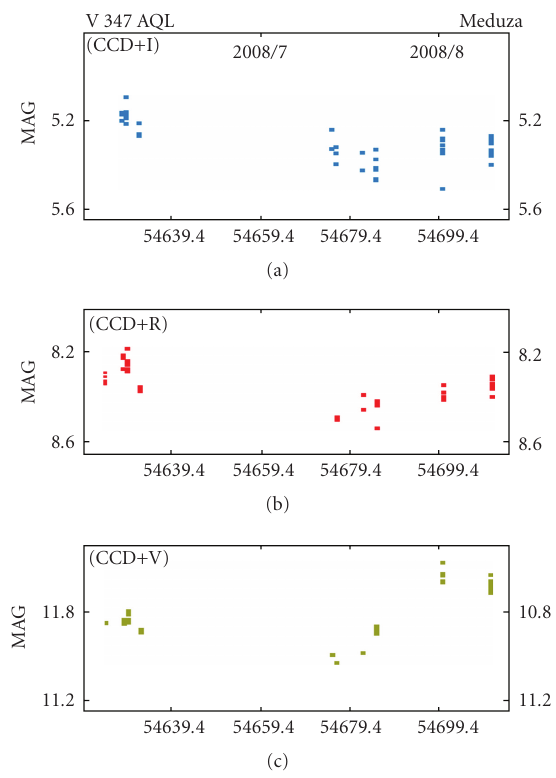
Figure 12: The VRI optical light curve V 347 Aql = HESS J1908+063 provided by the Altan Observatory, Czech Republic. The object exhibits both light changes as well as colour